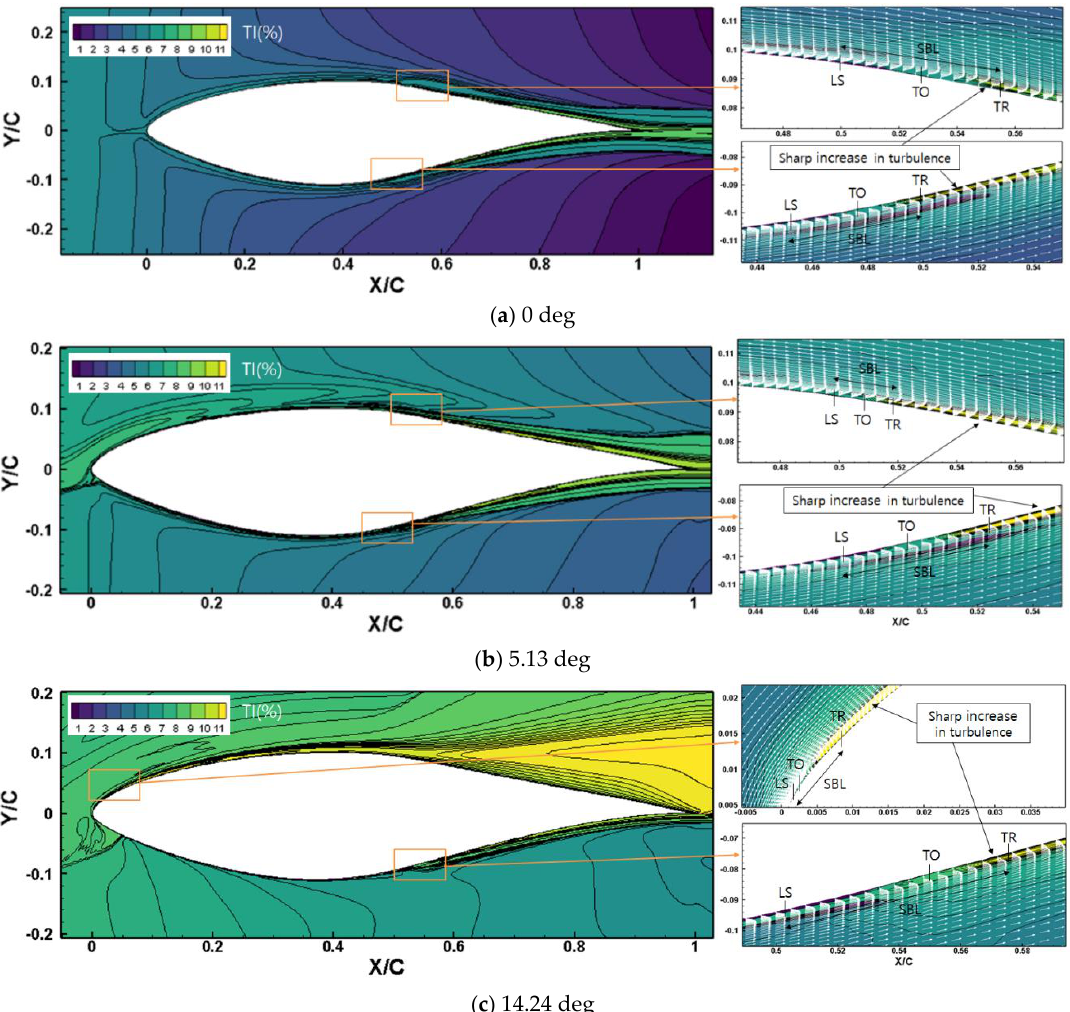
Figure 8. Distribution of TI and overlapped distributions of velocity vector and TI at selected AoAs of 0° ( a ), 5.13° ( b ), and 14.24° ( c ) (left panels) and close-up views of the LSB on the S809 airfoil (right panels). The points of laminar separation (LS) followed by turbulent reattachment (TR), the transition onset (TO) between them, and SBL are also marked for the pressure and suction surfaces of the airfoil.